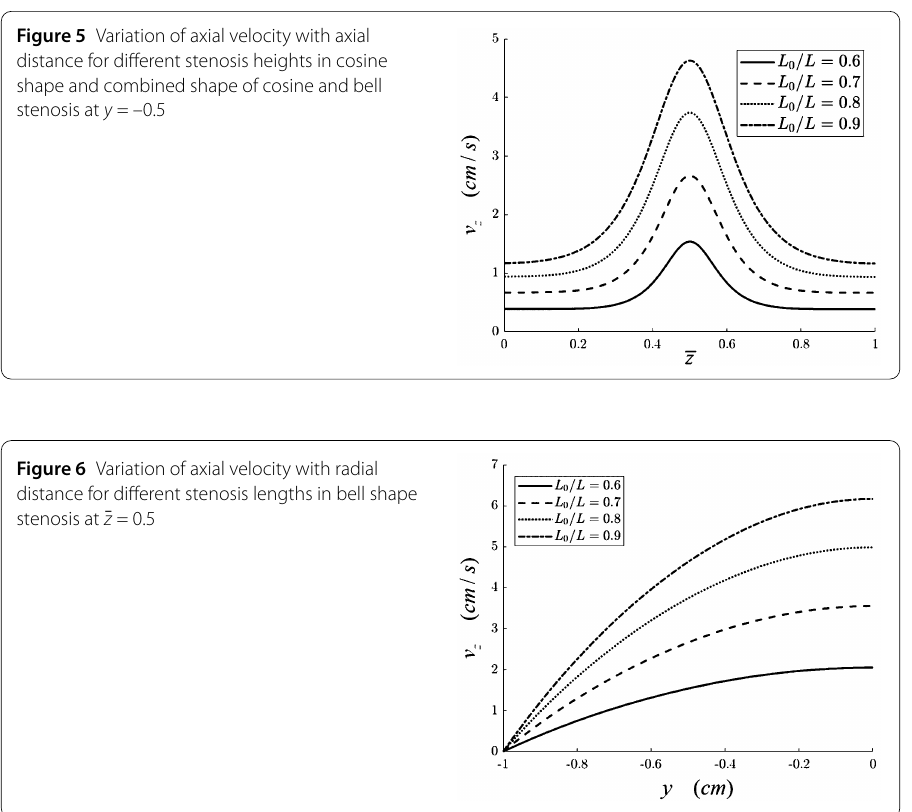
Figure 5 Variation of axial velocity with axial distance for different stenosis heights in cosine shape and combined shape of cosine and bell stenosis at y = –0.5